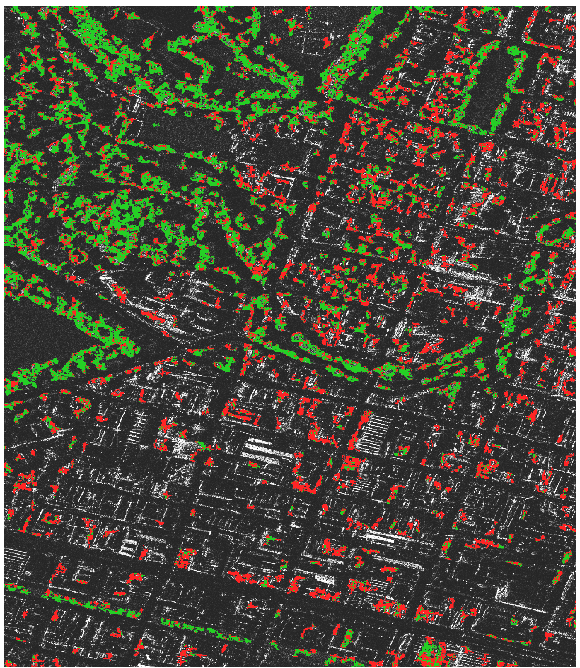
Figure 8. Subimage of the TerraSAR-X image of Christchurch. Separation of vegetation (green) from debris-like texture (red).